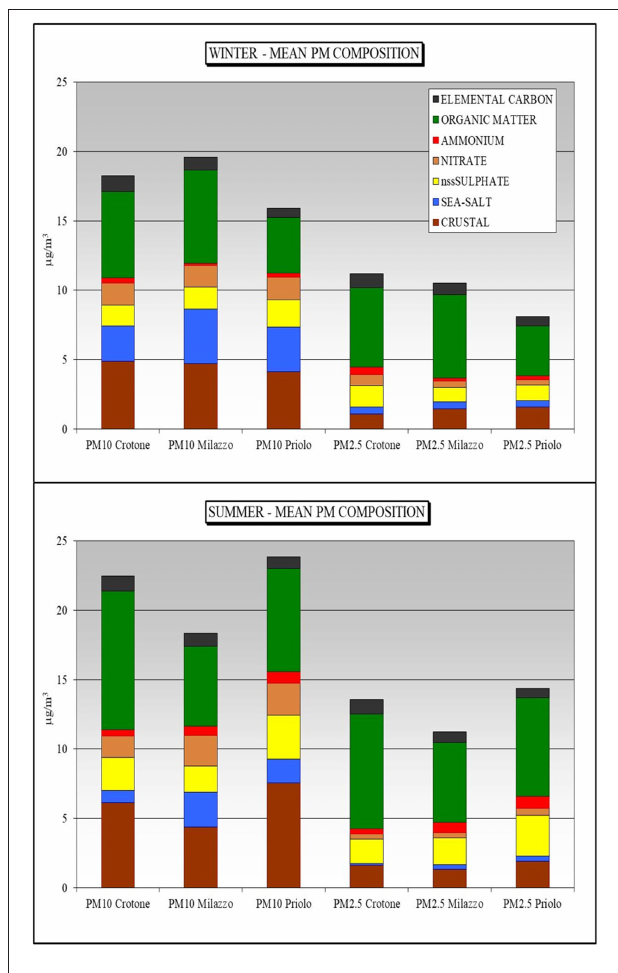
FIGURE 10 | Chemical composition of PM 10 and PM 2.5 at the three considered AERCAs.